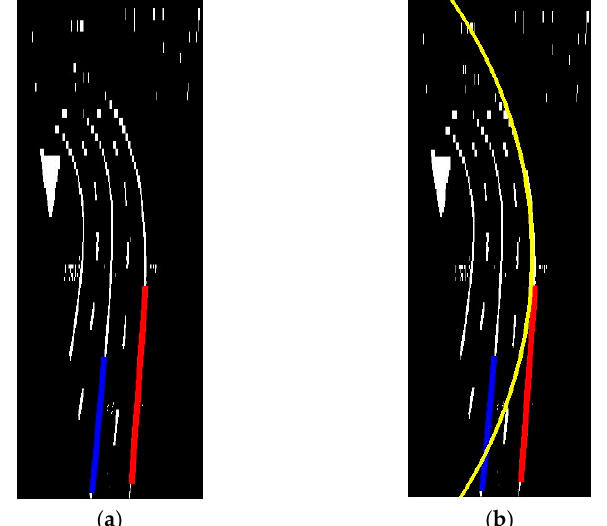
Figure 26. Comparison between measured value (blue), KF estimation (Orange), and true value (Red) of circle detection.